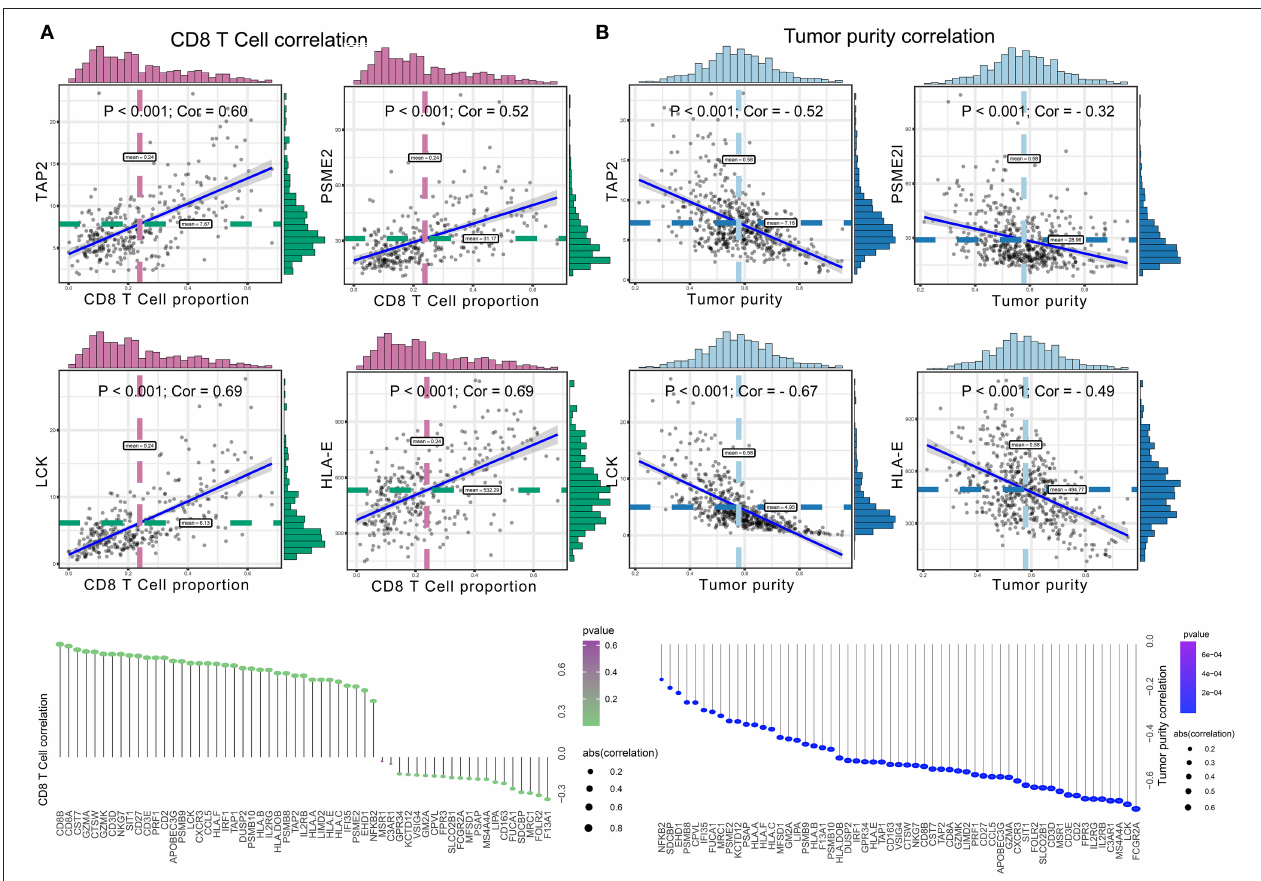
FIGURE 7 | (A) The correlation between co-expressed gene of M2 macrophage and CD8 + T cell, with significantly positive relations as TAP2 ( P < 0.001; Cor = 0.60), PSME2 ( P < 0.001; Cor = 0.52), HLA – E ( P < 0.001; Cor = 0.69), and LCK ( P < 0.001; Cor = 0.69). (B) The correlation between co-expressed genes of M2 macrophage and tumor purity, with significantly negative relations as TAP2 ( P < 0.001; Cor = − 0.52), PSME2 ( P < 0.001; Cor = − 0.32), LCK ( P < 0.001; Cor = − 0.67), and HLA-E ( P < 0.001; Cor = − 0.49).